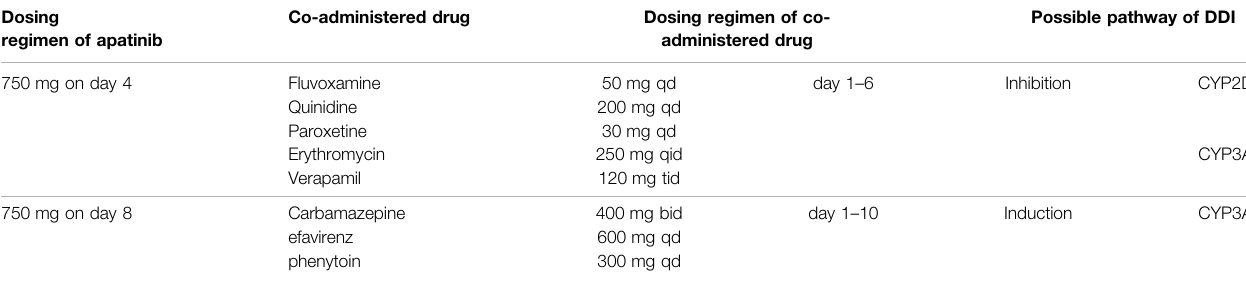
TABLE 2 | Summary of the outline of the trial design for apatinib DDI simulation Dosing regimen of